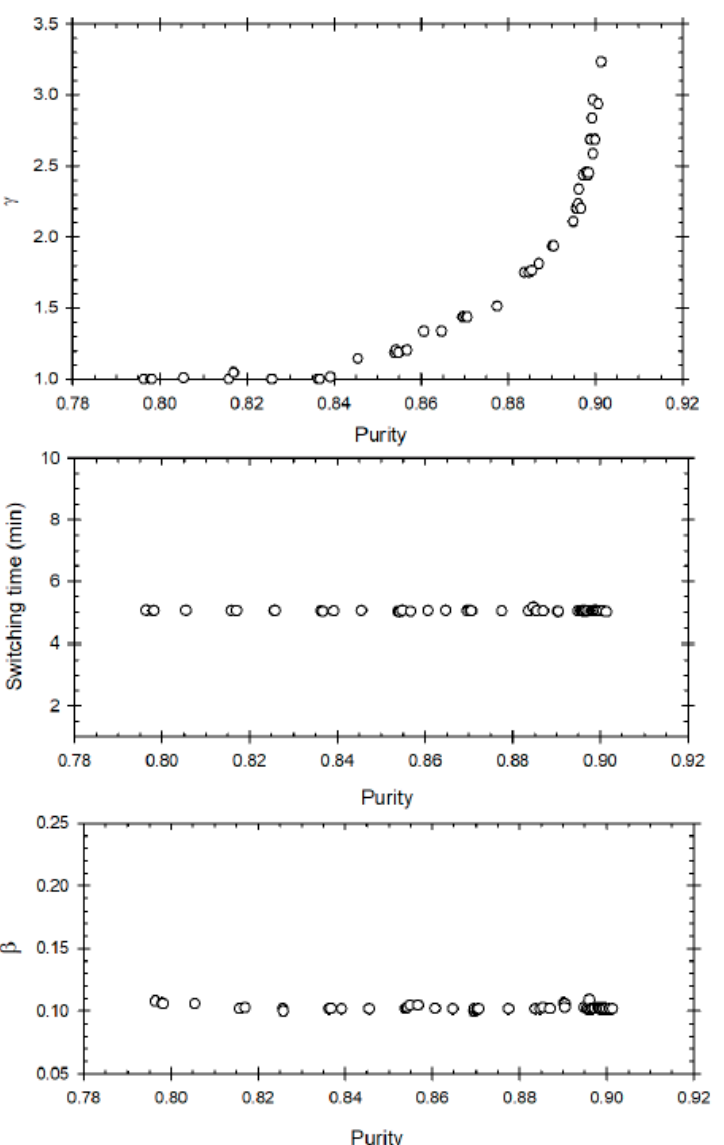
Figure 4. Case 1.2 Existing set-up. Maximization of Purity and minimization of Desorbent flow rate: Pareto optimal solutions and corresponding operating variables.